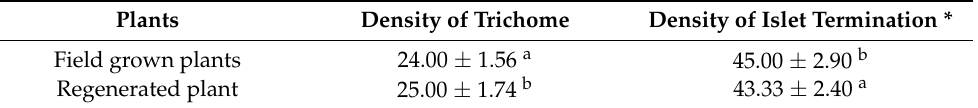
Table 6. Density of trichome and vein-islet termination density from regenerated and field grown (donor)